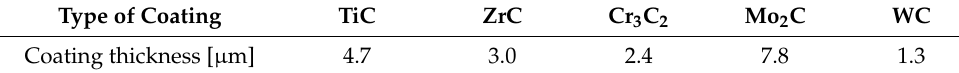
Table 2. Thicknesses of the deposited carbide coatings (average of five measurements).